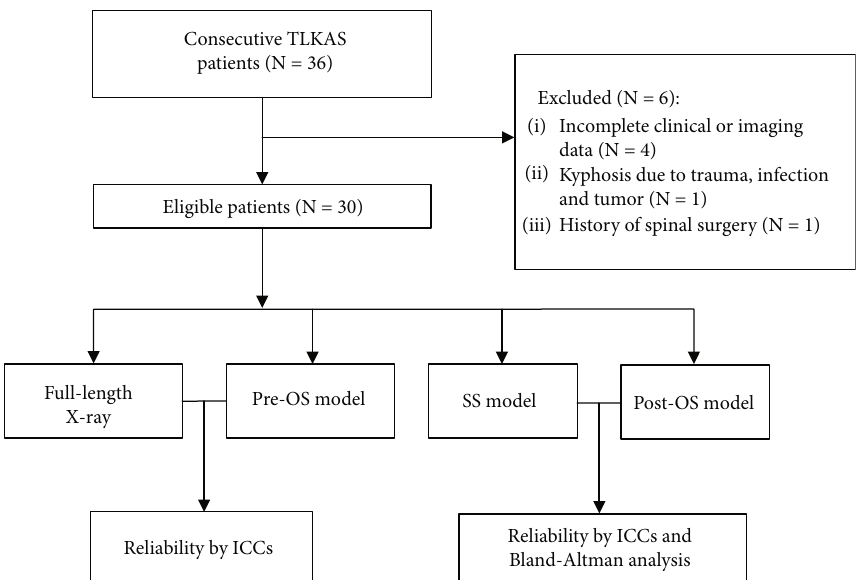
Figure 1: The fl owchart. TLKAS: thoracolumbar kyphosis secondary to ankylosing spondylitis; Pre-OS: preoperative original 3D spine; SS: simulated 3D spine; Post-OS: postoperative original 3D spine.